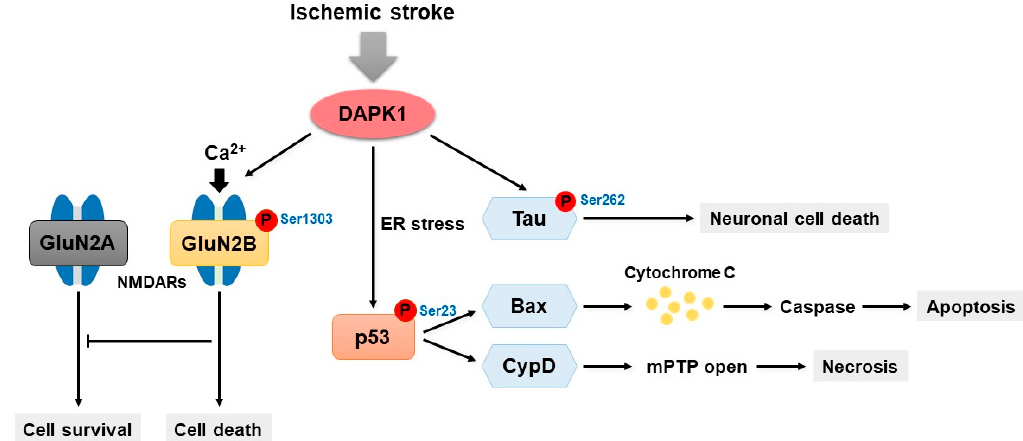
Figure 2. Signal transduction of DAPK1 in ischemic stroke. DAPK1 induces neuronal cell death by multiple signaling mechanisms upon ischemic stroke. Activated DAPK1 directly interacts with NMDA receptor GluN2B and phosphorylates it at Ser1303, thereby increasing neuronal cell death by enhancing Ca 2+ influx. Upon ER stress, death domain of DAPK1 binds to the p53 DNA binding motif, followed by phosphorylation of p53 at Ser23. The interaction between DAPK1 and p53 activates both apoptotic and necrotic signaling pathways by death-related genes such as Bax and CypD through transcriptional- and mitochondrial-dependent mechanisms. Moreover, DAPK1 directly phosphorylates tau at Ser262 resulting in accumulation in the dendritic spines, which promotes neuronal cell death. mPTP, mitochondrial permeability transition pore.